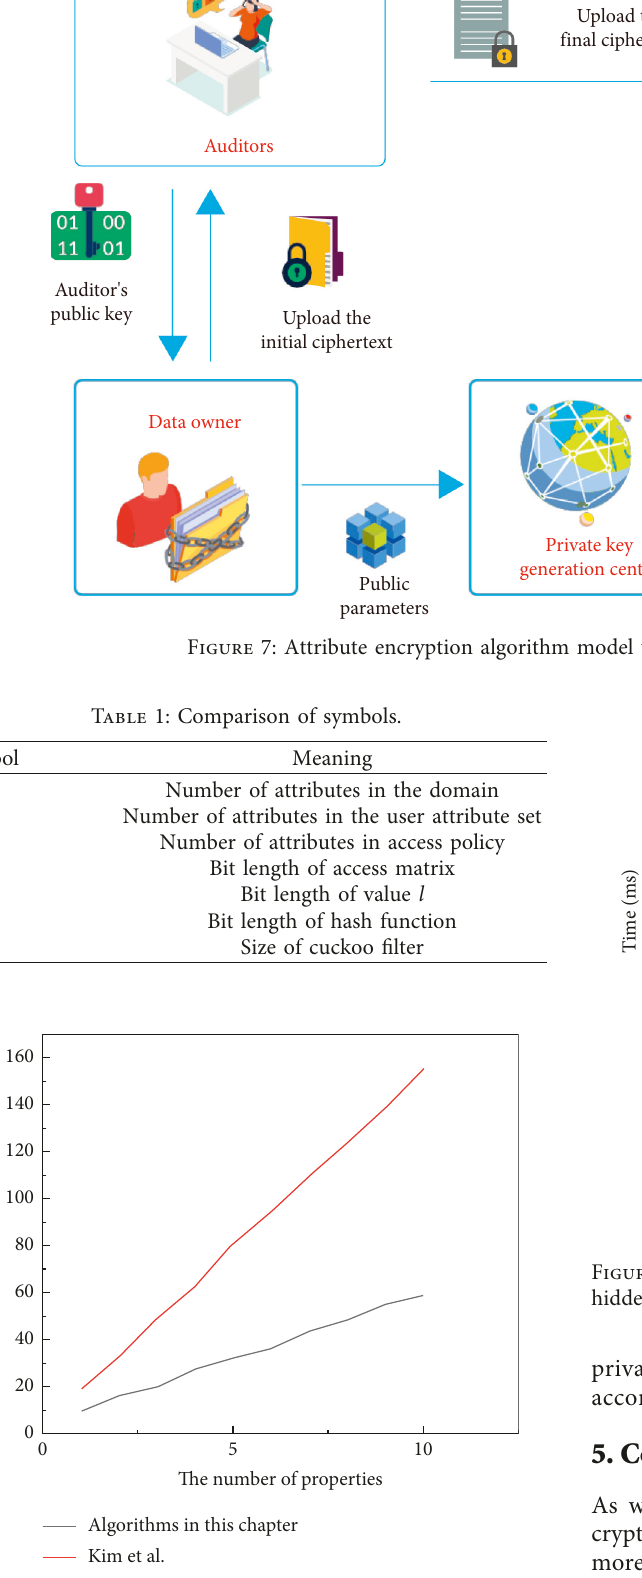
Figure 8: Encryption time of attribute encryption algorithm with hidden and verifiable policy.